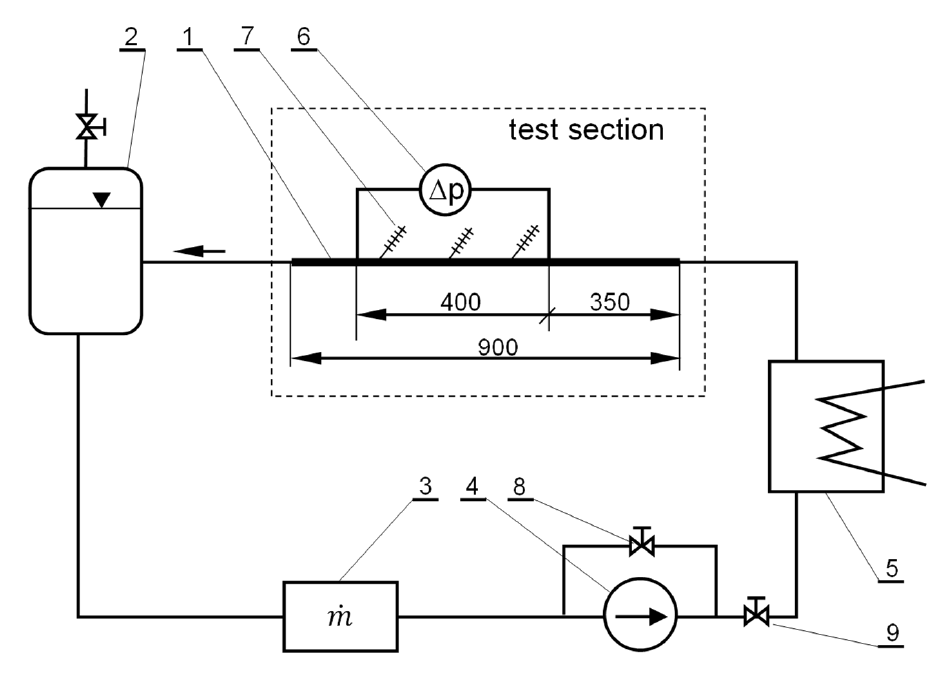
Figure 3. Diagram of the test stand; 1—test section, 2—working liquid tank, 3—flow meter, 4—working medium pump, 5—heat exchanger, 6—differential pressure sensor, 7—thermoelectric thermometer, 8—bypass control valve, 9—main control valve.